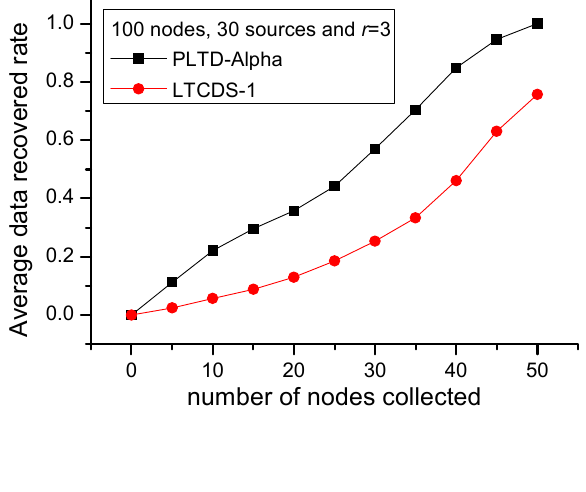
Figure 12. Data recovery performance in a disaster network with n = 100, k =